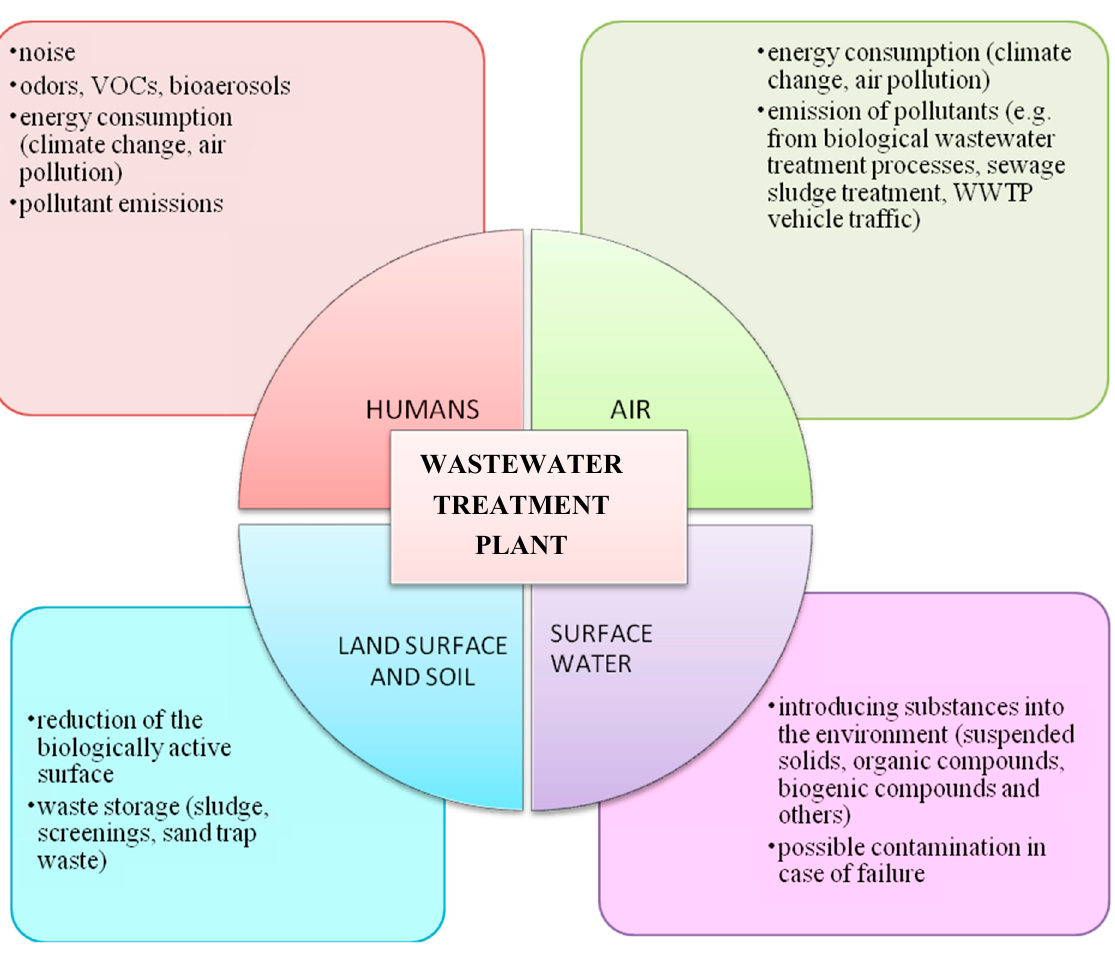
Figure 3. Main environmental aspects of wastewater treatment plants.